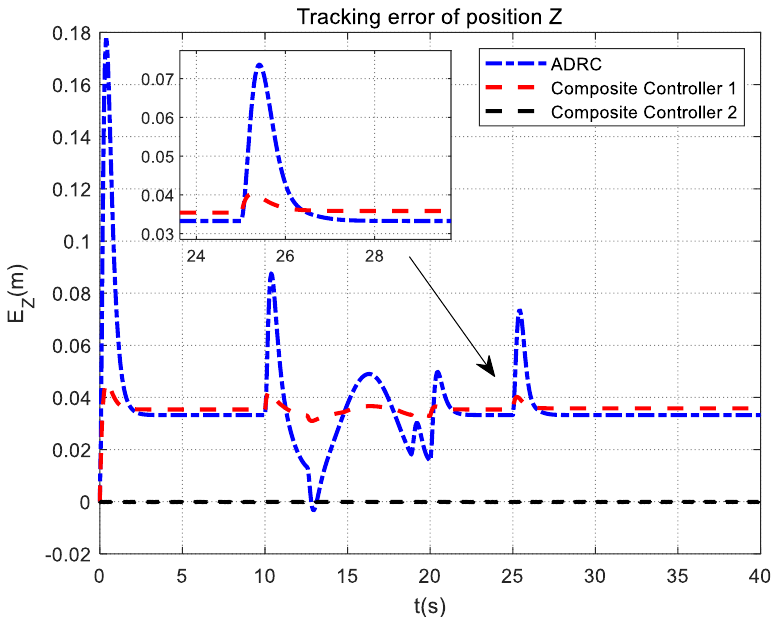
Figure 14. Tracking error of position Z control for QUAV under actuator constant fault and disturbance condition.